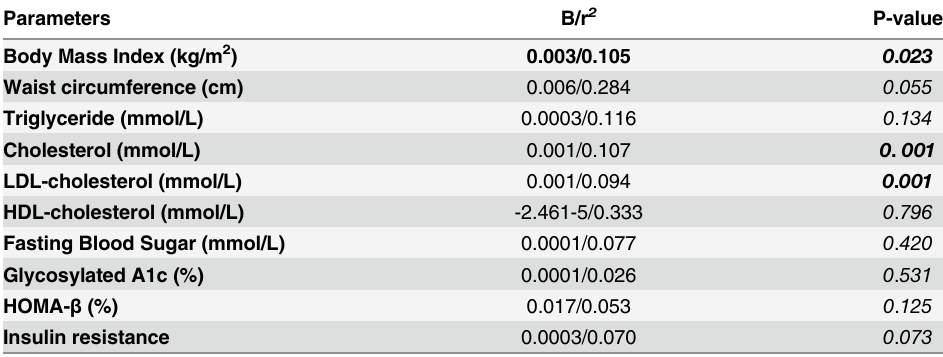
sulfonylurea (SU), and thiazolidinedione (TZD) with or without insulin] (n = 28); those receiv- ing combination therapy with metformin (metformin, SU, and TZD with or without insulin) (n = 241); and non-treated diabetes (n = 8). The general linear model indicated that patients treated with monotherapy (metformin) had significantly lower serum levels of sCD26/DPP-IV [1048 (275) ng/mL] than patients receiving combination therapy without metformin [1355 (166) ng/mL] ( p = 2.9×10 − 5 ). Like- wise, patients treated with combination therapy that included metformin had significantly lower serum levels of sCD26/DPP-IV [1205 (229) ng/mL] than patients receiving combination therapy without metformin [1335 (166) ng/mL] ( p = 0.023) (Table 6). This association was confirmed by multiple linear regression analysis, and the results remained significant only for patients treated with monotherapy that included metformin (B = -201.6, p = 0.041), after adjusting for age, race, gender, BMI, A1c, and duration of diabetes (Table 7). Table 5. Association of fasting serum levels of sCD26/DPP-IV with diabetic and metabolic parameters among normal subjects. Parameters B/r 2 P-value Body Mass Index (kg/m 2 ) 0.003/0.105 0 . 023 Waist circumference (cm) 0.006/0.284 0 . 055 Triglyceride (mmol/L) 0.0003/0.116 0 . 134 Cholesterol (mmol/L) 0.001/0.107 0 . 001 LDL-cholesterol (mmol/L) 0.001/0.094 0 . 001 HDL-cholesterol (mmol/L) -2.461-5/0.333 0 . 796 Fasting Blood Sugar (mmol/L) 0.0001/0.077 0 . 420 Glycosylated A1c (%) 0.0001/0.026 0 . 531 HOMA- β (%) 0.017/0.053 0 . 125 Insulin resistance 0.0003/0.070 0 . 073 The results are presented as unstandardized coef fi cients; B, r 2 and (P-value) assessed using hierarchical linear regression adjusted for, age, race, and gender. Bold values are signi fi cant. B: coef fi cient for the relationship between the dependent variable “ metabolic syndrome and T2DM parameters ” and the independent variable “ DPP-IV level. ” The positive sign of the coef fi cient implies a direct relationship, and the negative sign implies an inverse